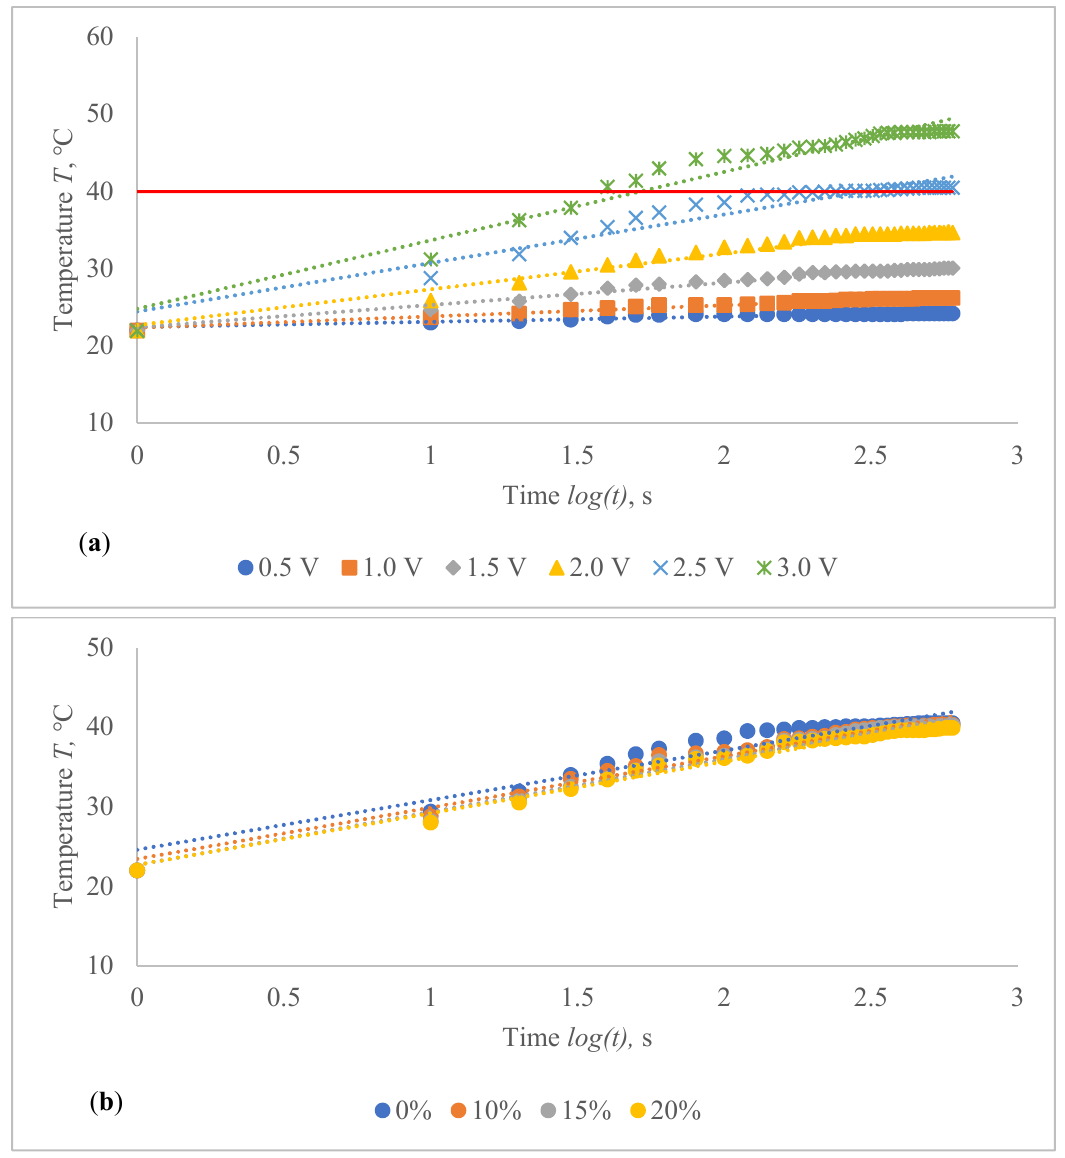
Figure 12. Temperature changes of CF_LY3 structured electro-conductive composite fabric during the 600 s period: ( a ) at non-stretched state by applying different voltage; and ( b ) at the different stretch levels by applying 2.5 V. Red line indicates the target